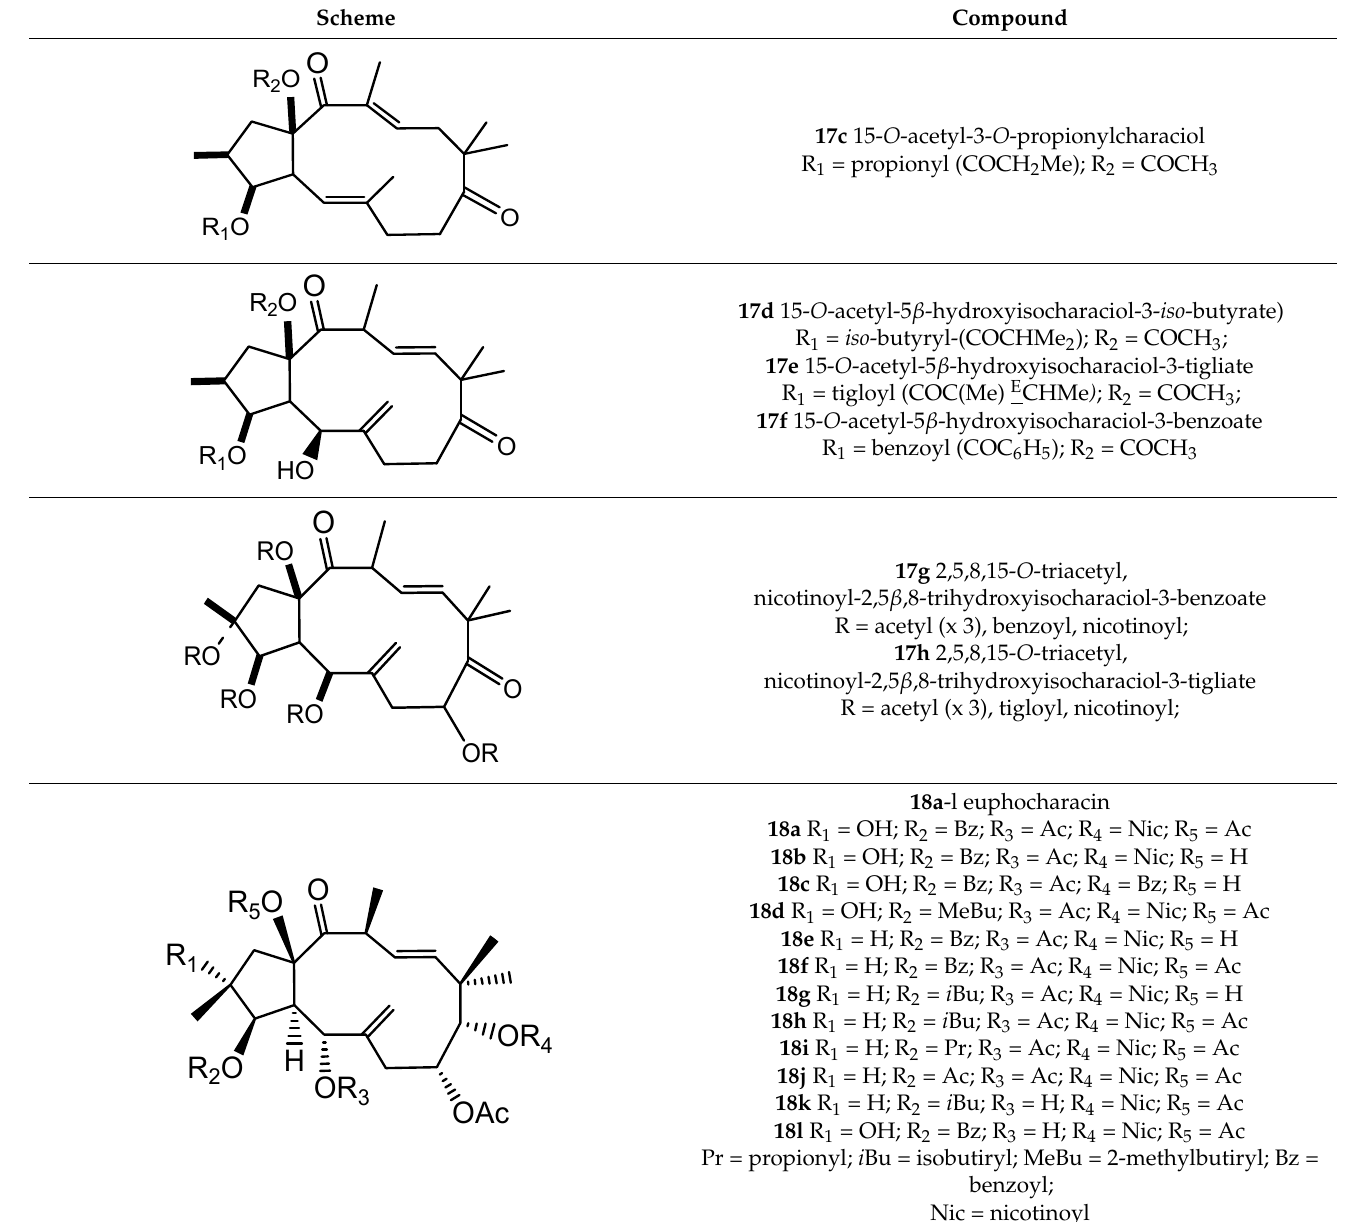
Table 2. Cont. Scheme